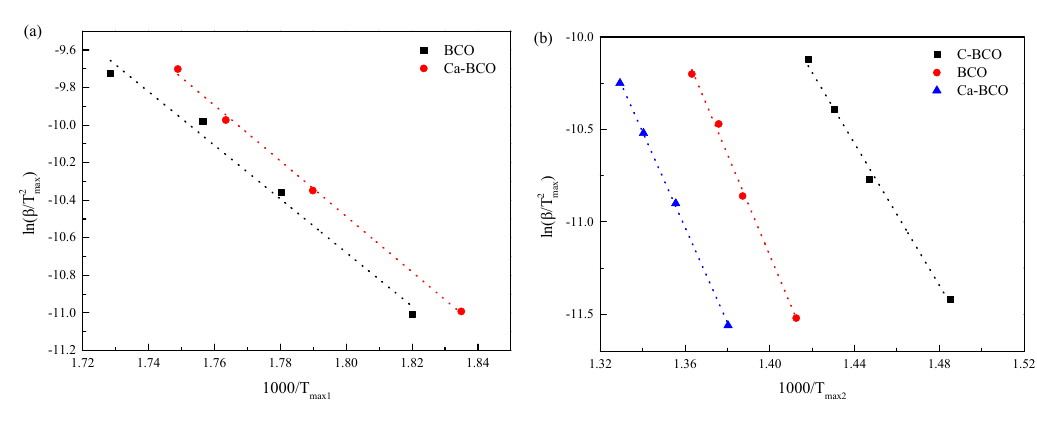
Figure 3. Plots of ln( β / T max 2 ) versus 1000 / T max of (BiO) 2 CO 3 samples for the first mass loss zone ( a ) and the main mass loss zone ( b ) based on Kissinger’s method. Table 2. Apparent activation energies of nanostructured (BiO) 2 CO 3 samples based on the Kissinger’s method.